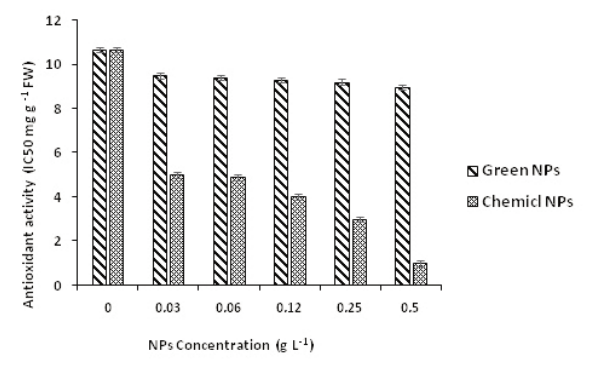
Fig. 9 ­ The influence of AgNPs type and concentration on antioxidant capacity in Allium cepa . Means ± SD of six replicates. The same letter denotes lack of a statistically significant difference (Tukey, p<0.01).